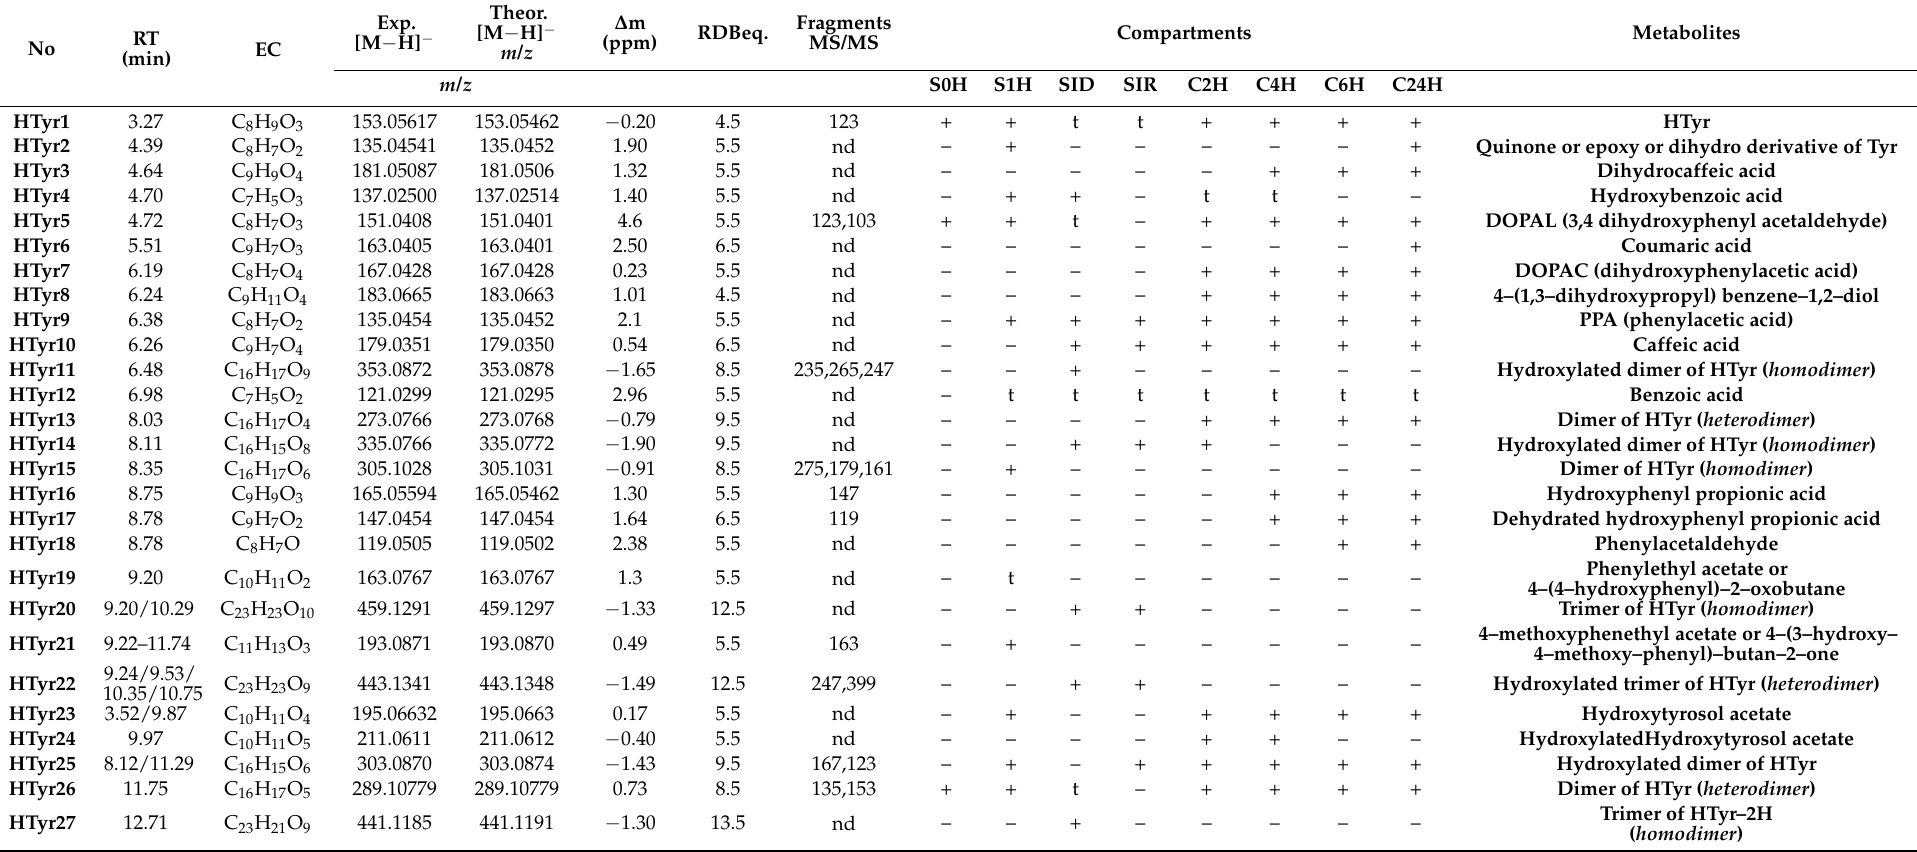
Table 1. Chromatographic and spectrometric information of HTyr identified